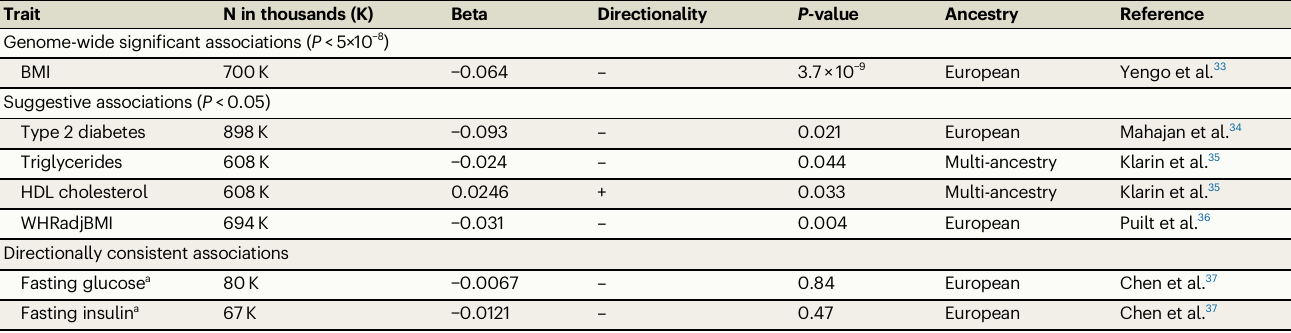
Table 1 | Results from query of GWAS studies with publicly available summary statistics